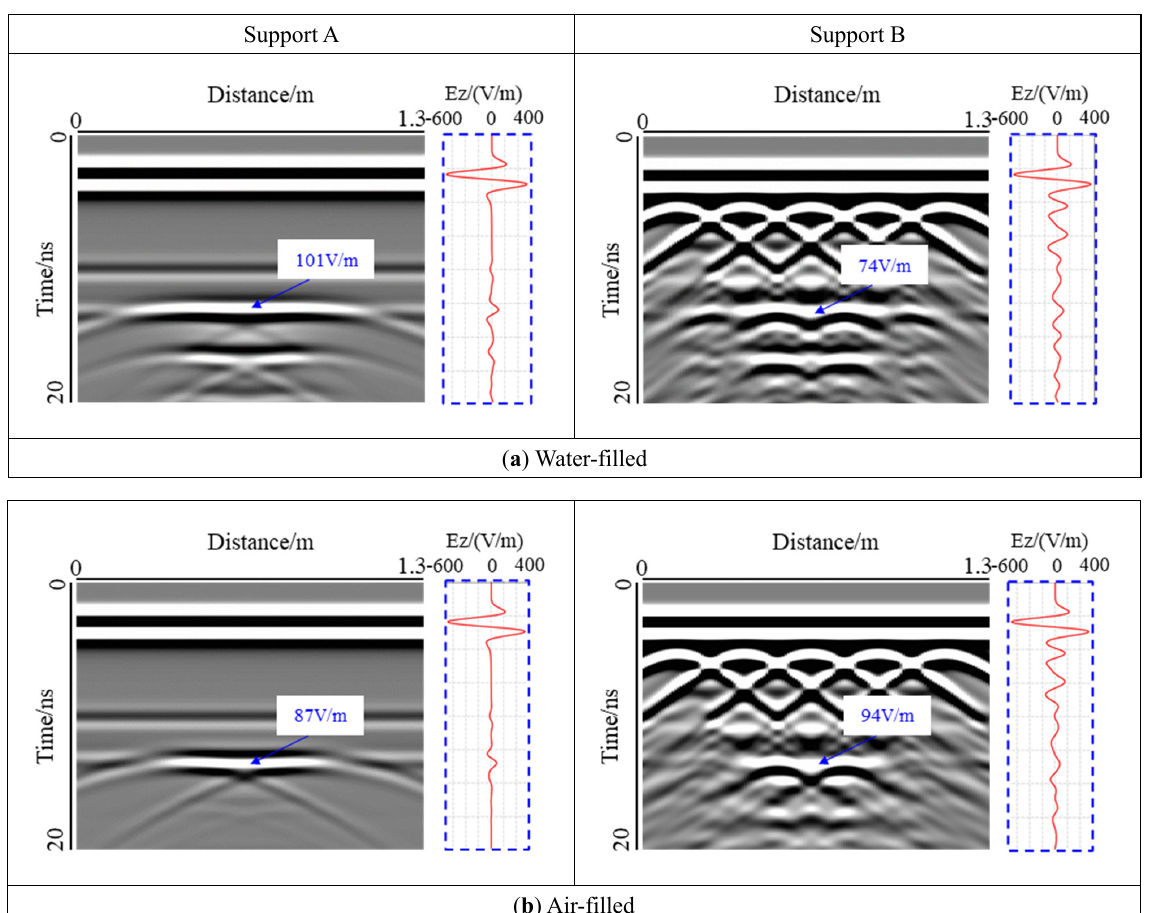
Figure 12. The influence of water-filled and air-filled. Compared with the air-filled void, water filling increases the response range of the void and produces a virtual image.